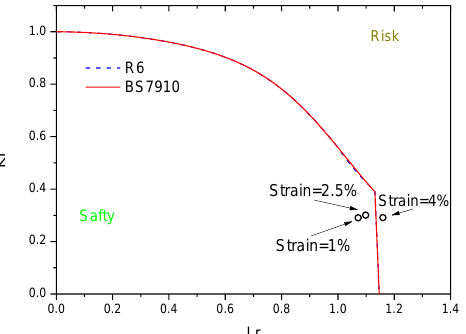
Figure 12. Failure assessment curve of the pipe by BS7910 and R6 with initial crack depth of 4 mm. The results of the failure assessment curve are more conservative than the FEA method.